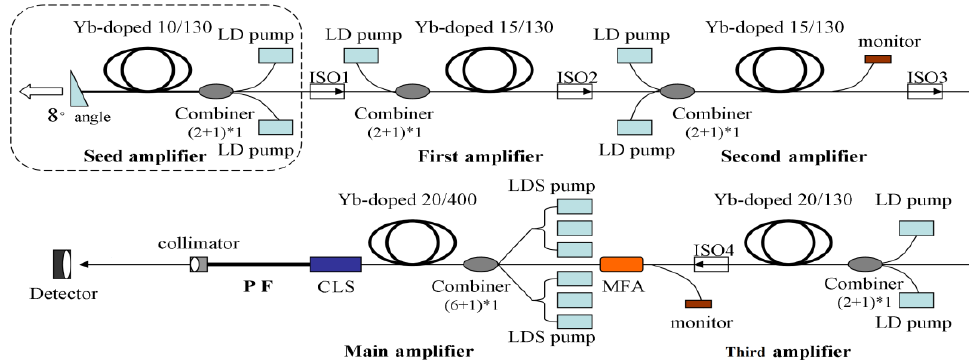
Figure 1. All-fiber amplifier system of ASE